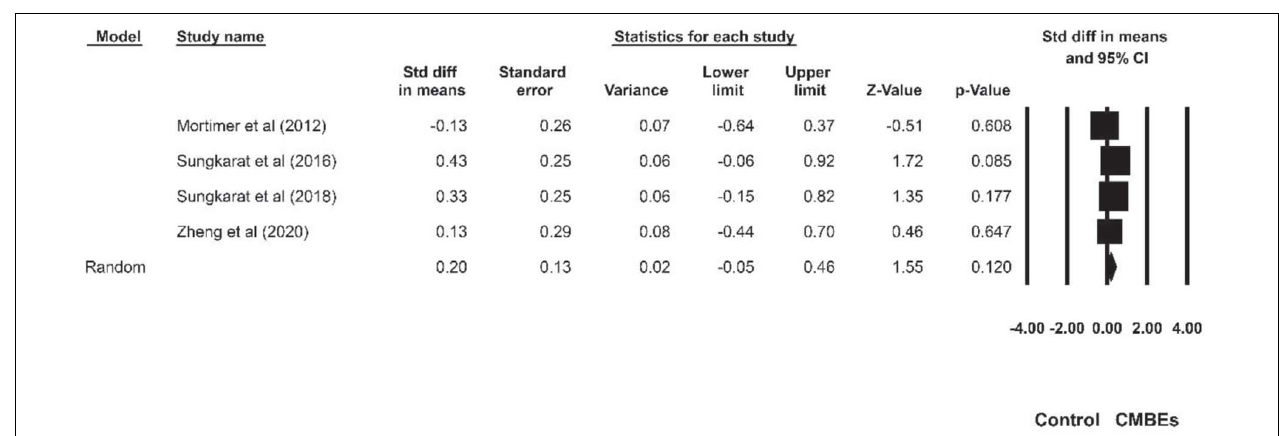
FIGURE 7 | Forest plot of Chinese mind-body exercises on